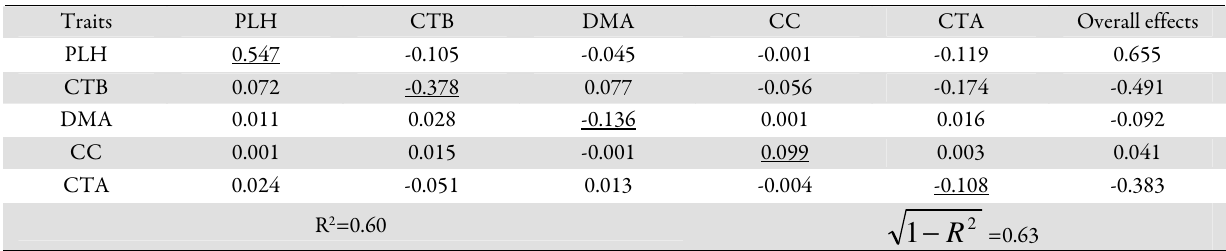
Tab. 4. Direct and indirect effects of second order predictor variables on grain yield by agronomic score as response variable